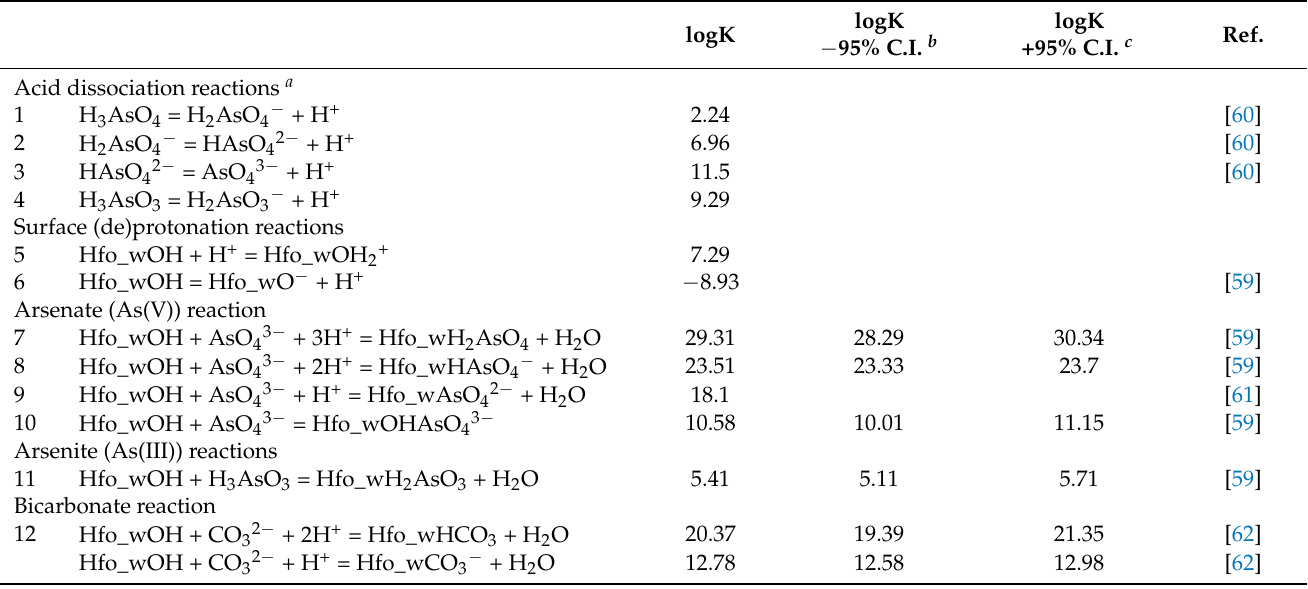
Table 1. Acid dissociation and surface complexation constants and reactions for arsenate, arsenite, and bicarbonate.